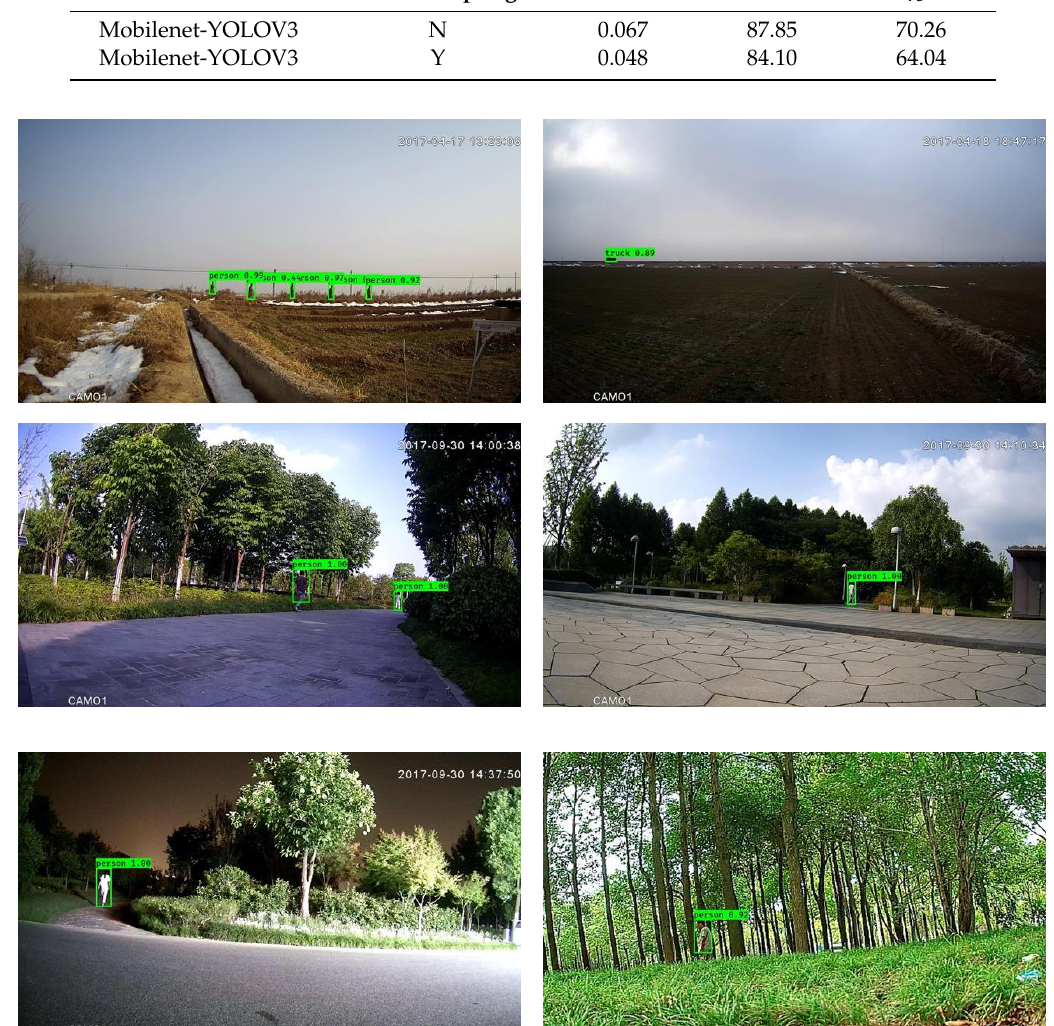
Figure 4. Outcomes of the framework with Mobilenet-YOLOV3 and